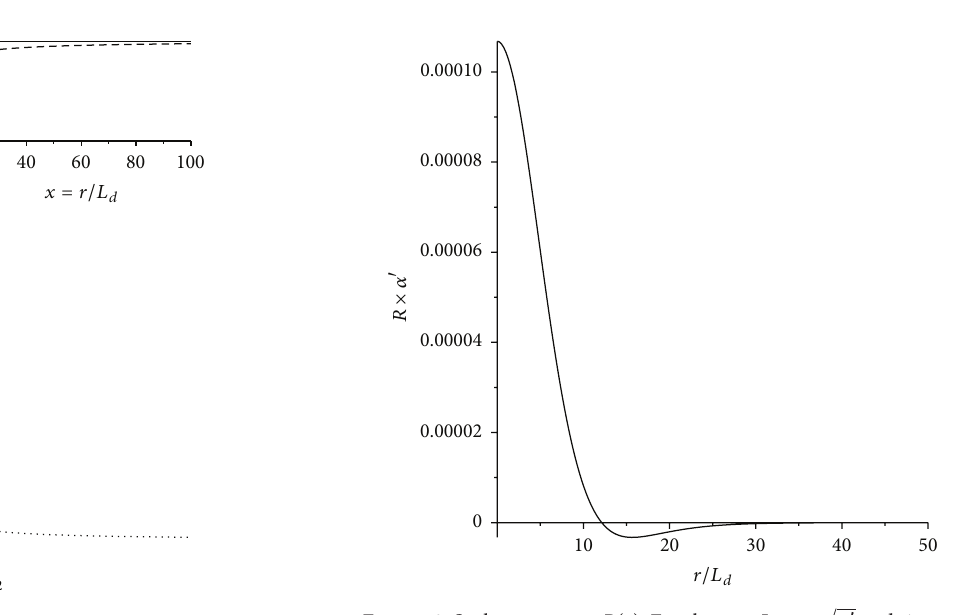
Figure 3: Scalar curvature 𝑅(𝑟) . For the case 𝐿 𝐷3 = √𝛼 󸀠 and sin 𝜓 = 1 , the dimensionless scalar curvature, 𝑅 × 𝛼 󸀠 , is plotted as a function of the scaled radial coordinate, 𝑟/𝐿 𝑑 Figure 1: Embedding Functions of the 5 𝐷3 -branes for the gauge group 𝑆𝑈(5) . The scaled coordinate 𝑥 4 /𝐿 𝐷3 is plotted as a function of the scaled radial coordinate, 𝑟/𝐿 𝑑 , for the 5 𝐷3 -branes. The radial coordinate, 𝑟 , is scaled by the size of the dyon, 𝐿 𝑑 , and the 𝑥 4 coordinate is scaled by the separation between the two 𝐷3 -branes 𝐷3 𝑟 . 𝐷3 1 and 1 in the asymptotic limit of large